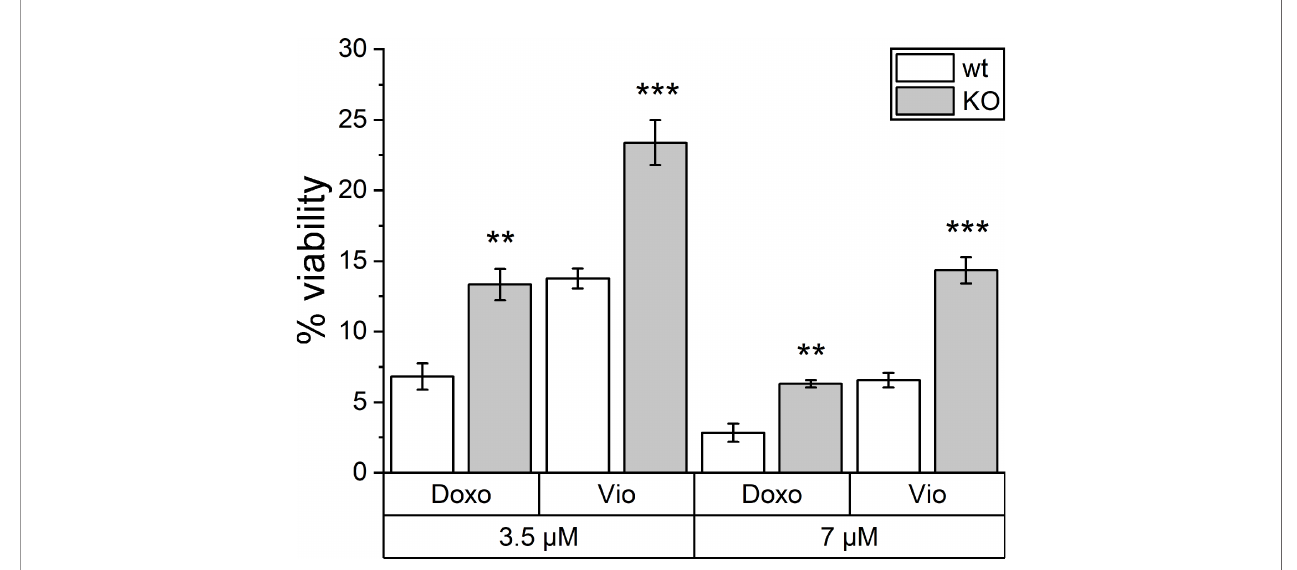
FIGURE 5 | Toxic effects of violacein against Nlrp3 knockout macrophages. BMMs from wildtype (wt) and Nlrp3 knockout (KO) mice were treated with violacein or doxorubicin, and cells were analyzed in an MTT assay 48 h after treatment. The viability of solvent control-treated wt and KO cells were set to 100%, respectively. ** p< 0.01, *** p<0.001.